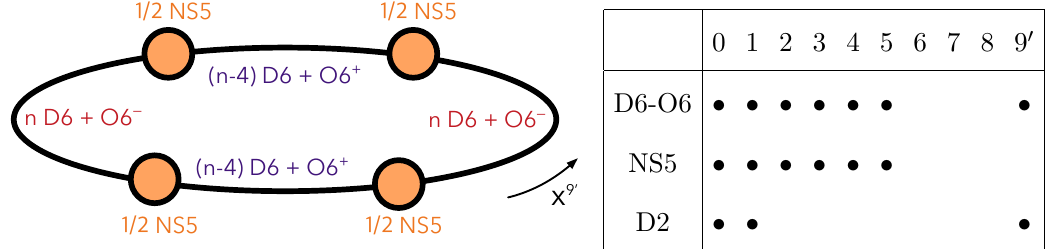
Figure 1. NS5-D6-O6 brane system at N =